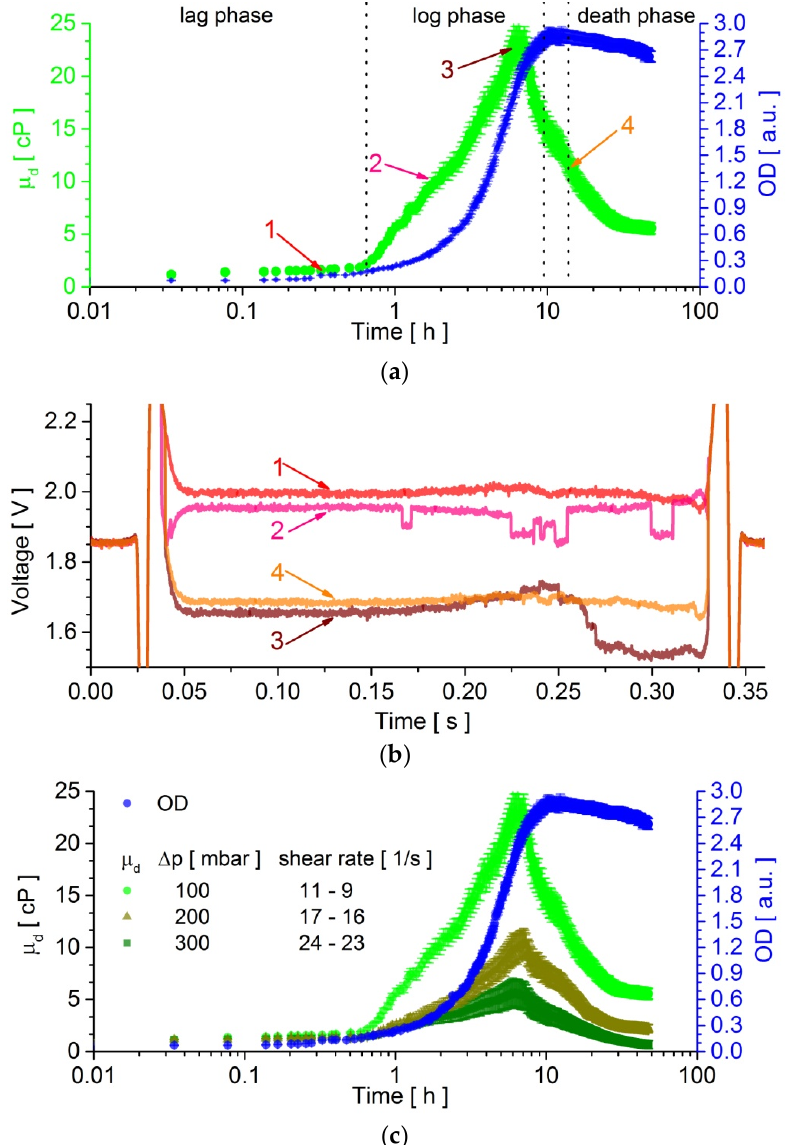
Figure 4. Time evolution of the droplet viscosity ( μ d ) and optical density (OD) for a circulating droplet filled with bacterial culture for ( a ) ∆ p continuous phase = 100 mbar and ( c ) ∆ p continuous phase = 200 and 300 mbar. The standard deviations of the OD and droplet viscosity over ten samples were marked on the graphs ( a , c ). The OD curve was reproducible for all three of the cases ( c ). The experiments were performed in temperature T = 37 °C. ( b ) The voltage signals (1–4) that were recorded by the sensors during the flow of a droplet under them for various viscosities of a sample (for ∆ p continuous phase = 100 mbar). Corresponding viscosity points were labeled at ( a ). The front of the droplet is on the left side of the graph.